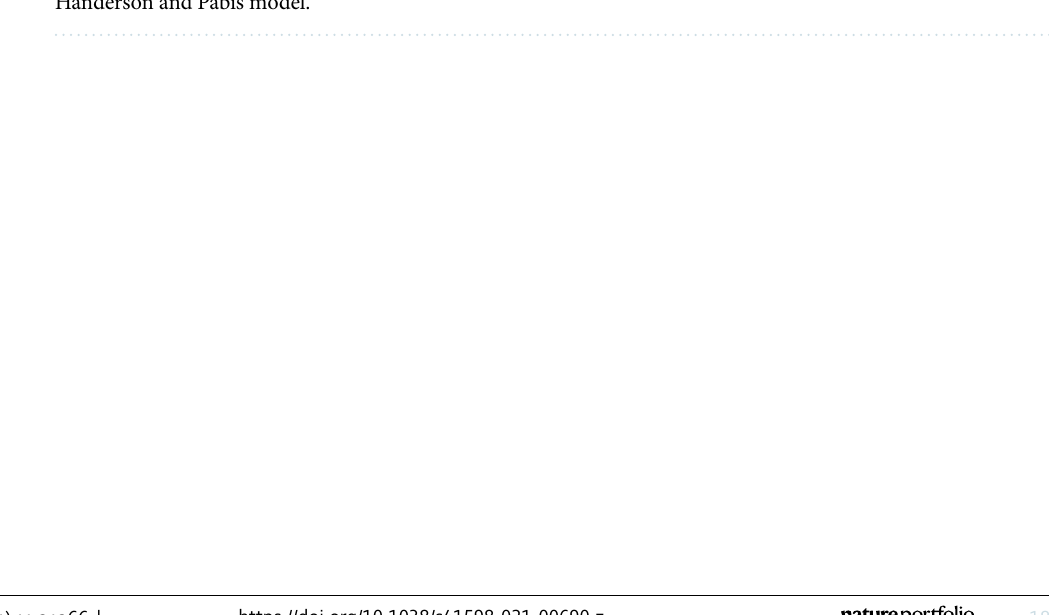
Figure 11. Comparison of experimental and predicted moisture ratio for both fig varieties by modified Handerson and Pabis